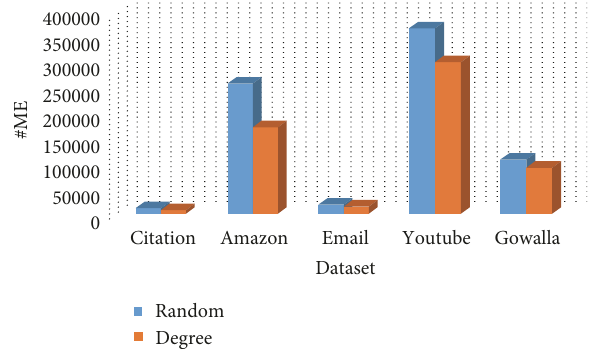
Figure 7: #ME of the different NMM methods.